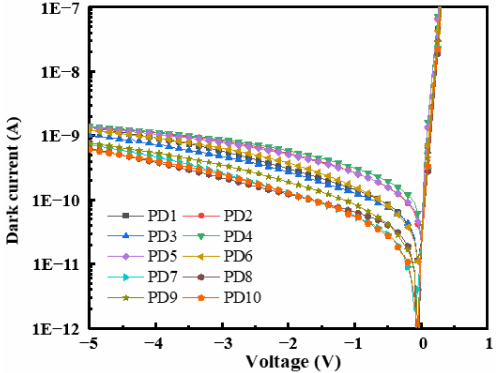
Figure 4. The dark current measurement result of the photodetector array. Photo-response measurements were carried out using a 1310 nm laser source, a tapered fiber with a 2.5 µ m spot size and a KEITHLEY 4200 Semiconductor Tester. The fiber output power and the bias voltage were fixed at 1.02 mW and − 5 V, respectively. The results of mea- sured photocurrent and calculated responsivity are shown in Figures 5a and 5b, respectively. All 10 WGPDs exhibited a uniform responsivity over 0.54 A/W without an AR coating. The quantum efficiency of the single PD was deduced to be 51%, which was consistent with the simulated value. By depositing an AR coating on the input facet, the quantum efficiency was expected to exceed 72% as the reflection loss would be negligible. Therefore, the double- cladding scheme could achieve high quantum efficiency without introducing a spot size converter in WGPD, which facilitated compact and large-scale on-chip integration.